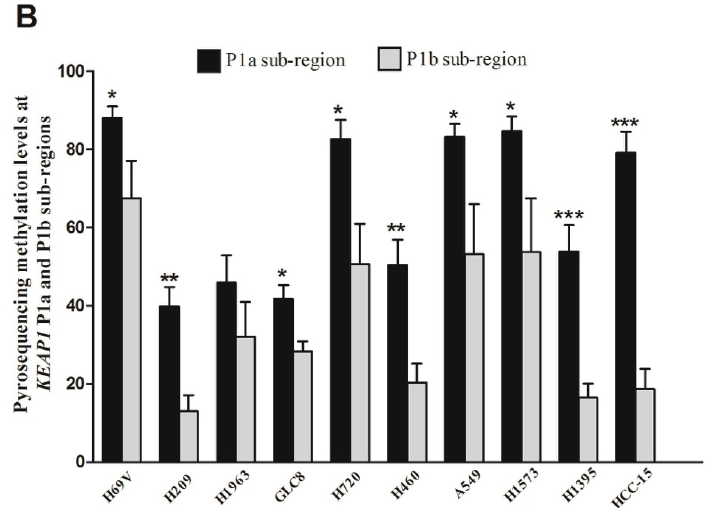
Figure 3. ( A ) Histograms showing the methylation levels detected by pyrosequencing at KEAP1 P1 promoter region in positive lung cancer cell lines. ( B ) Pyrosequencing methylation levels at P1a and P1b sub-regions of KEAP1 promoter in methylated lung cancer cell lines. p value was set at * p < 0.05; ** p < 0.01; *** p < 0.001, t -test.